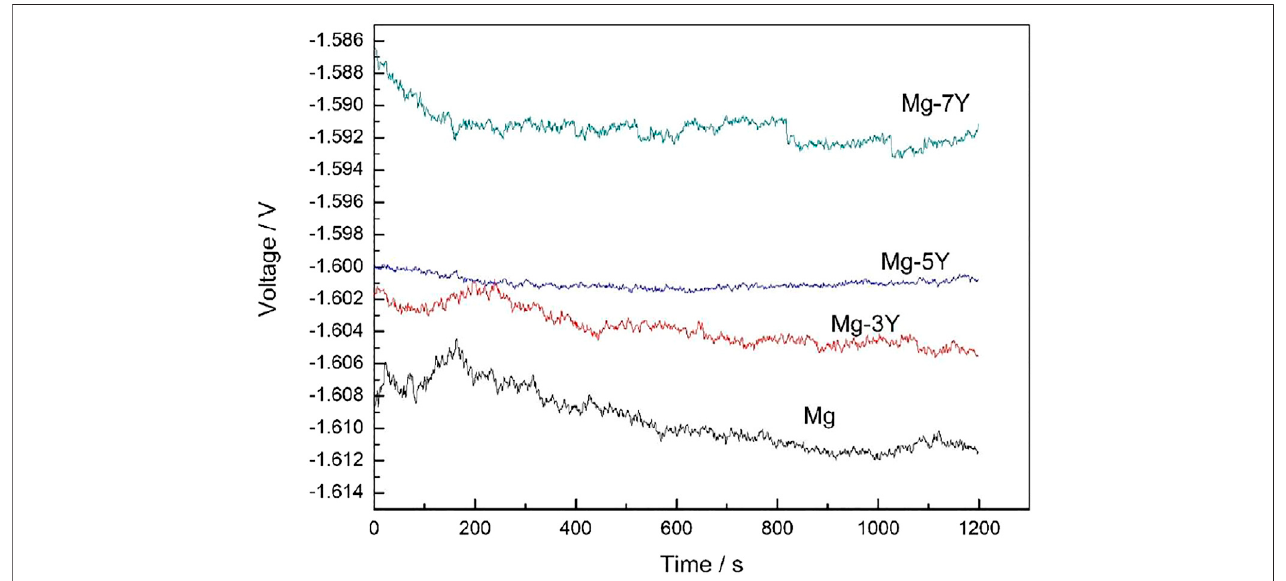
FIGURE 5 | The electrochemical open circuit potential of samples covered with oxidation fi lms in the surface measured in 3.5% NaCl solution.